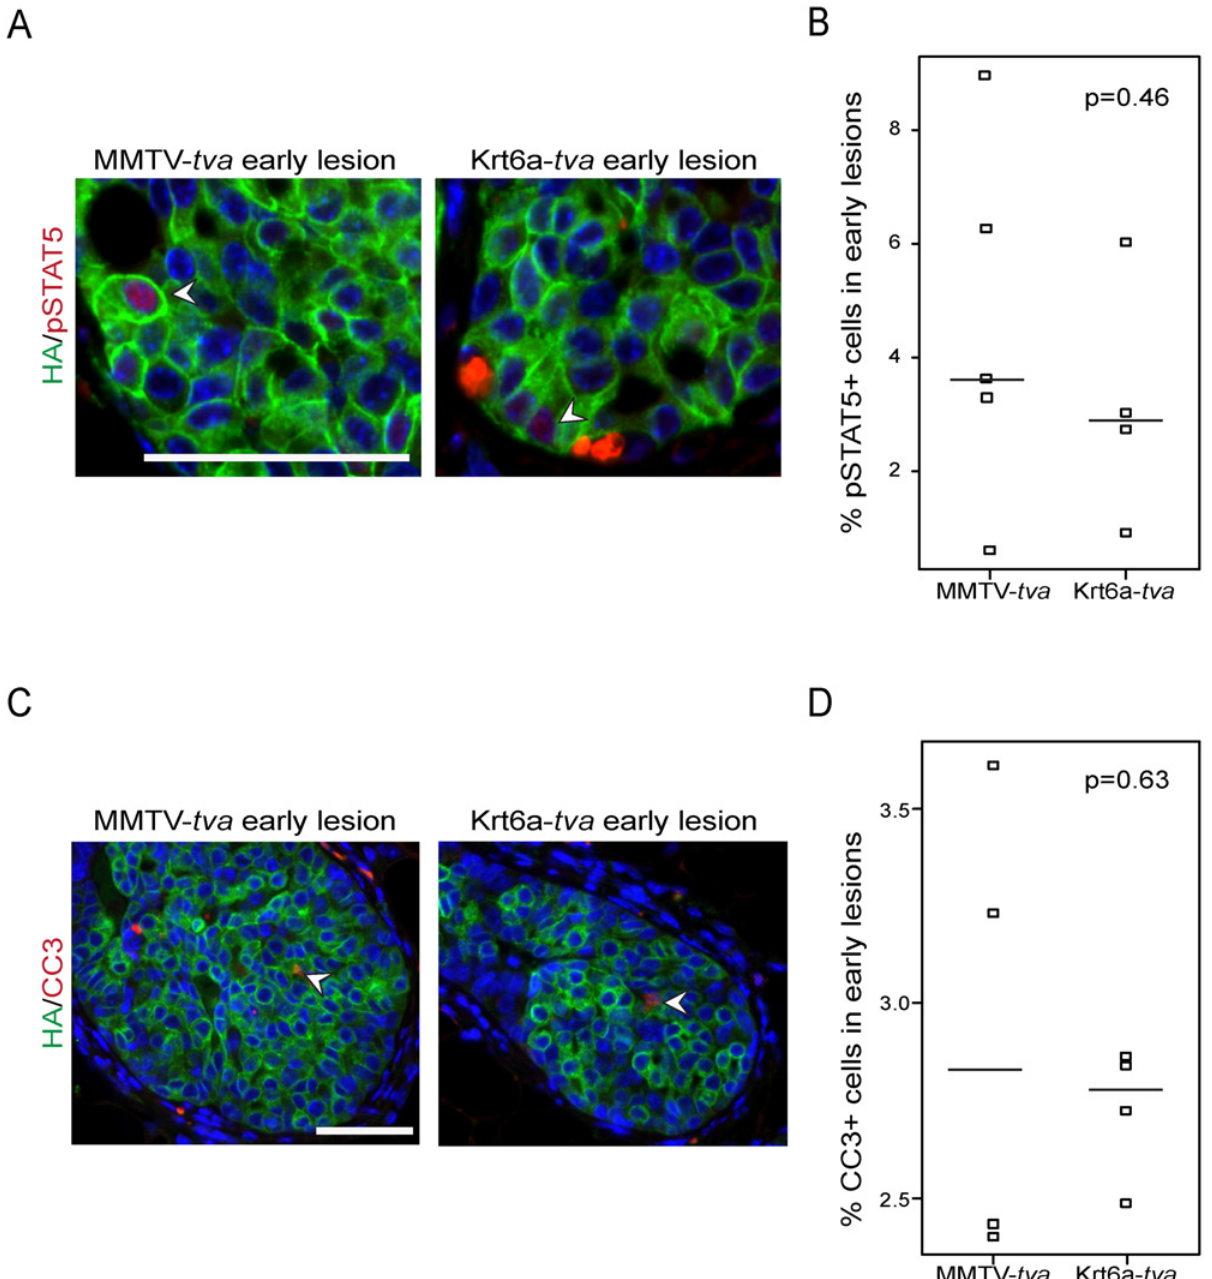
Fig 3. ErbB2-induced premalignant lesions in MMTV- tva and K6a- tva mice exhibit similar pSTAT5 and apoptosis. (A) Co-immunofluorescent staining for HA tagged-ErbB2 (green) and pSTAT5 (red) in tumors from MMTV- tva and K6a- tva mice, with (B) quantification. (C) Co-immunofluorescent staining for HA-tagged ErbB2 (green) and cleaved caspase 3 (red) in tumors from MMTV- tva and K6a- tva mice, with (D) quantification (scale bar: 50 um).